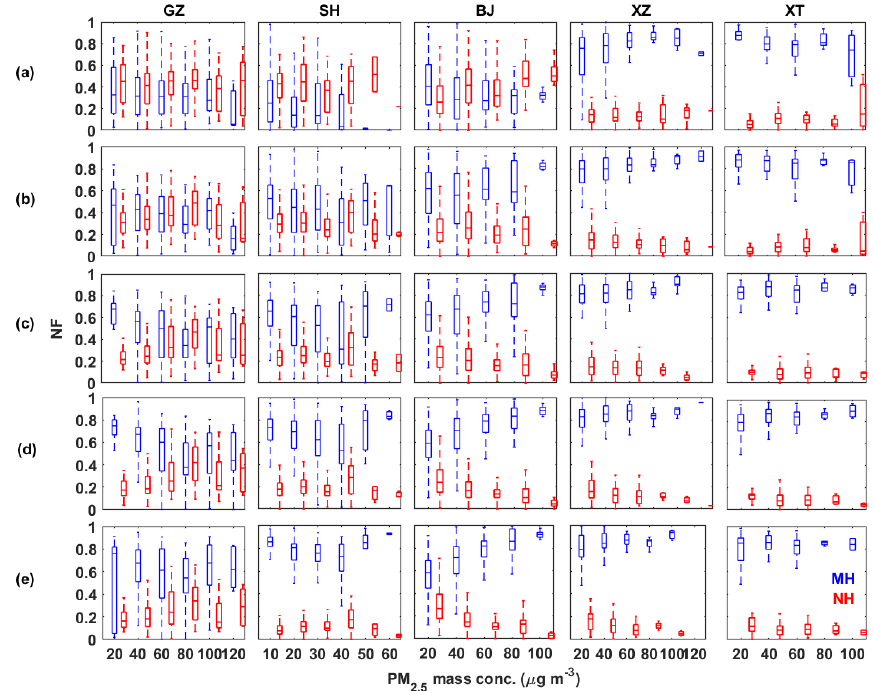
Figure 6. Box diagram for the number fraction of nearly hydrophobic (NH) mode (red) and more hygroscopic (MH) mode (blue) of (a–e) all selected diameter particles (40–200nm) under different PM 2 . 5 mass concentrations from all sampling sites. The horizontal line in the block diagram represents the median, the upper and lower borders represent the 25th and 75th percentiles, and the upper and lower borders of the dotted vertical line represent the 10th and 90th percentiles.